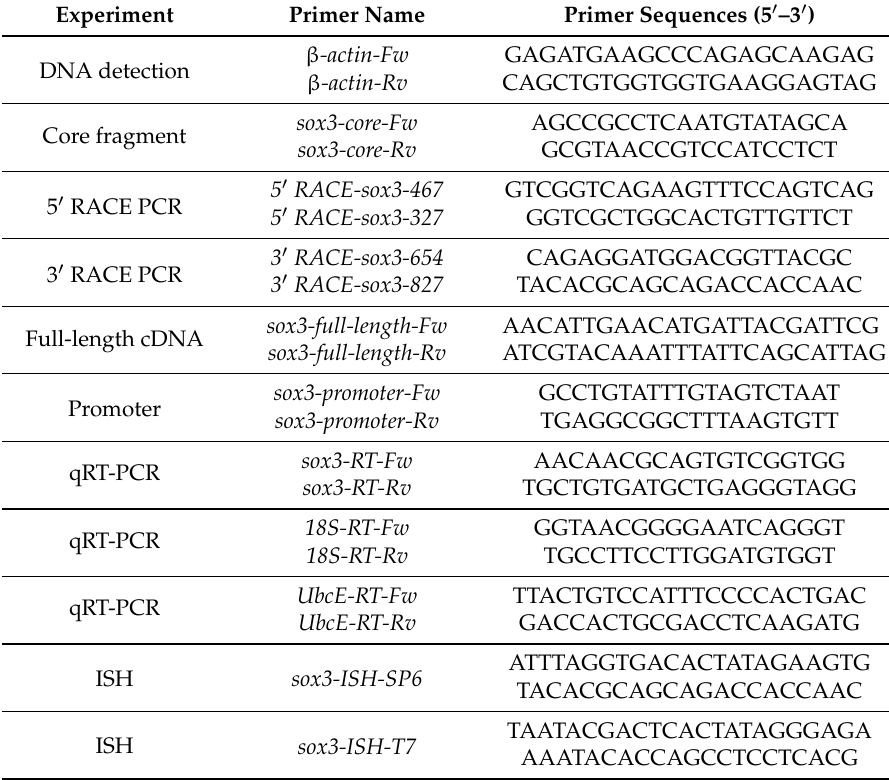
Table 1. Sequences of the primers used in this